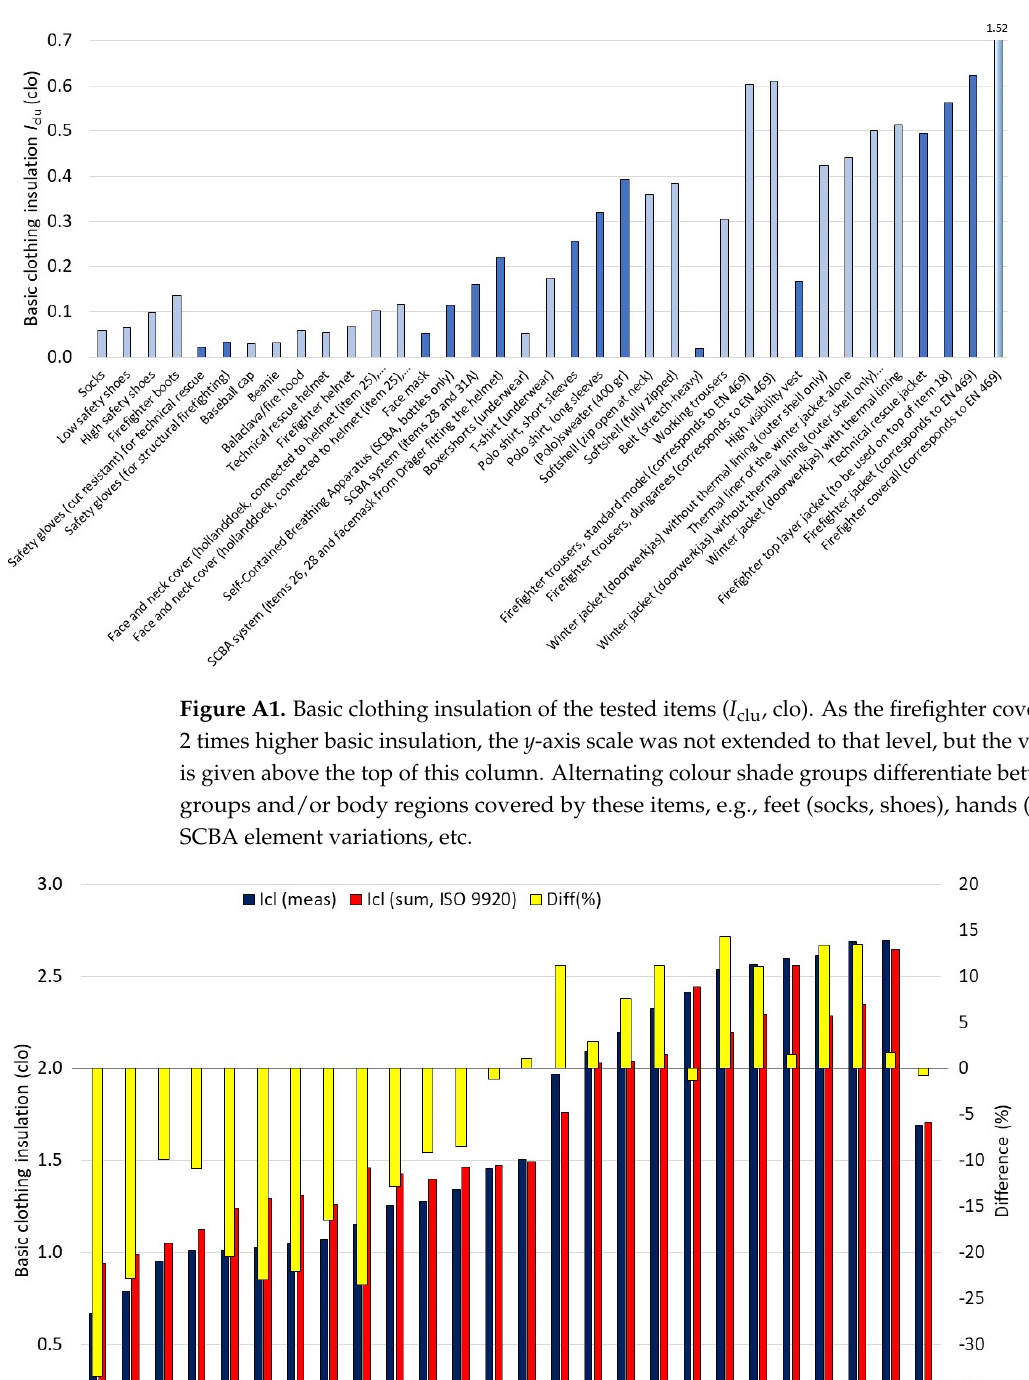
Figure A3. Uncorrected total evaporative resistances (Ret,raw), and according to Wang et al. [98], corrected total (Ret) and clothing (Recl) evaporative resistances of the tested clothing ensembles (m 2 Pa/W). For clothing combination descriptions, see Tables 1–3.